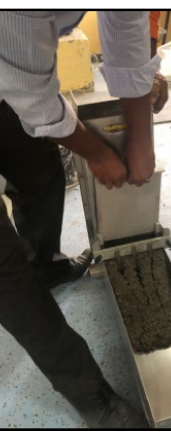
Figure 3. L-box test.